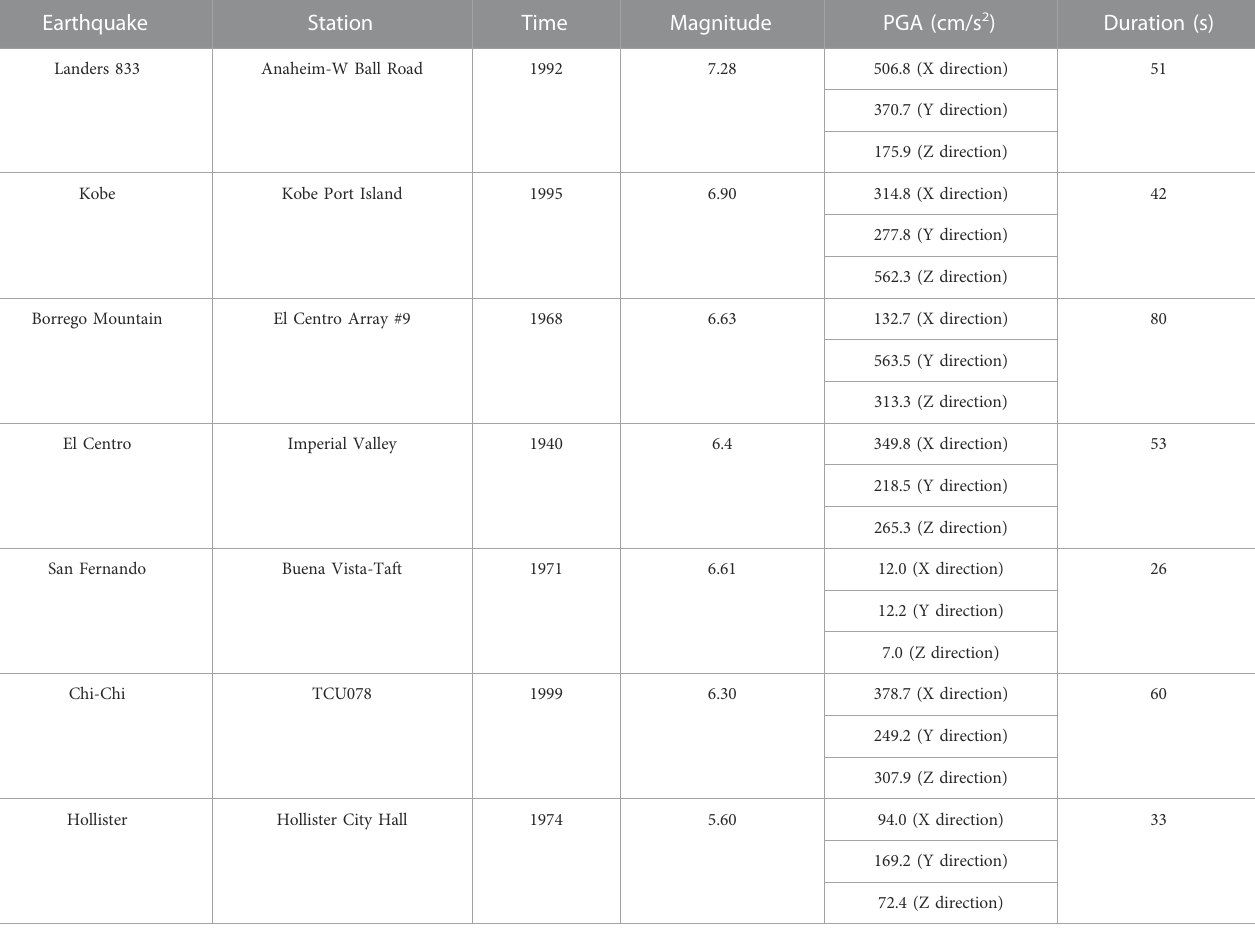
TABLE 6 Parameters of earthquakes.